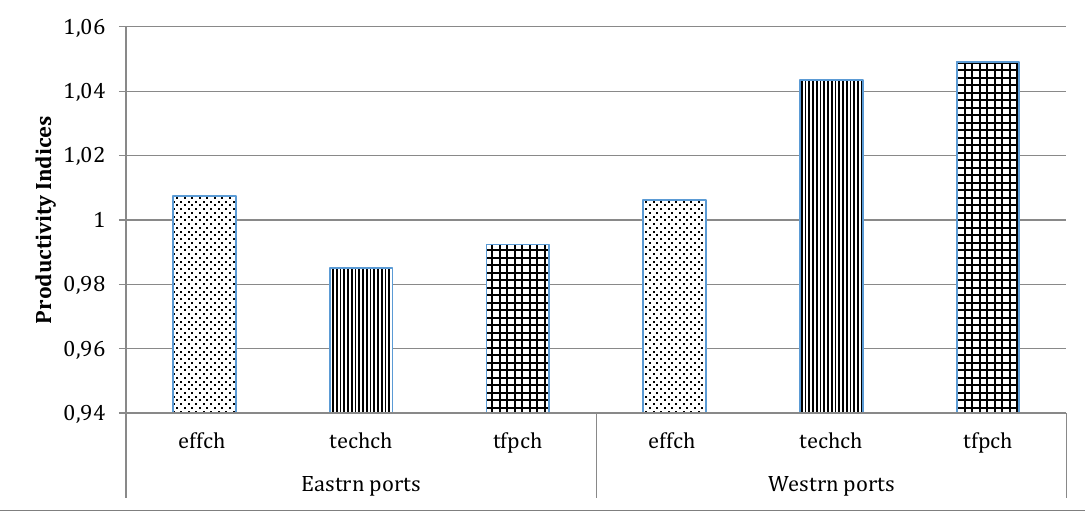
Figure 1: Distribution of productivity change indices (1991-2013) by location of